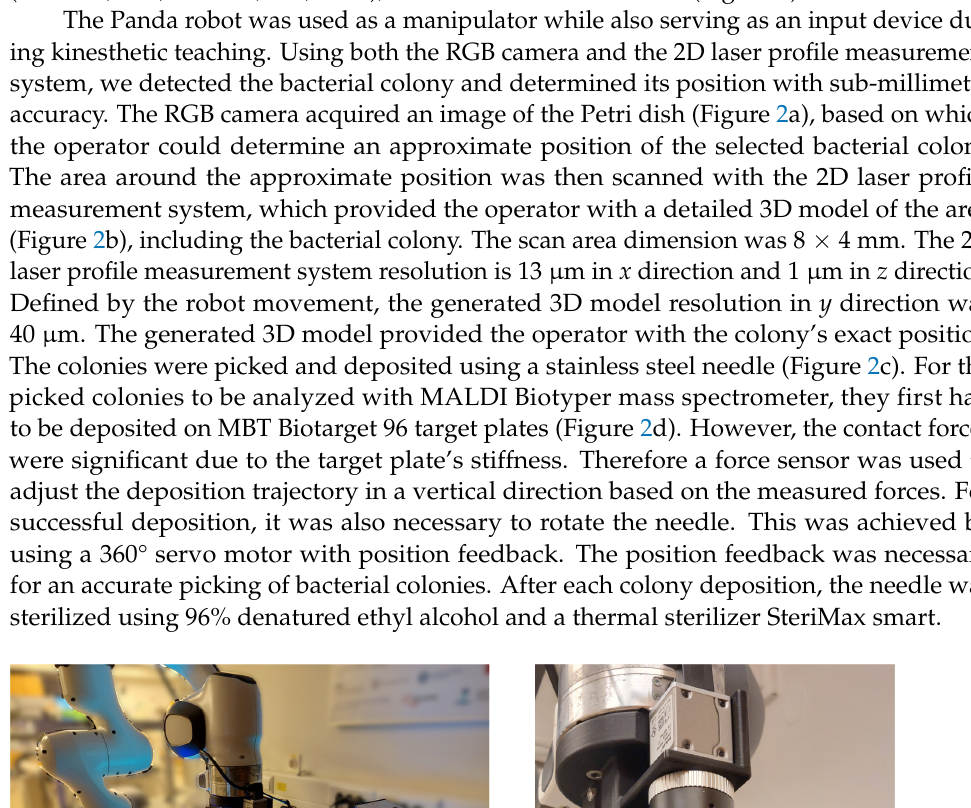
Inc., Natick, MA, USA). It was used to connect individual units (e.g., robot